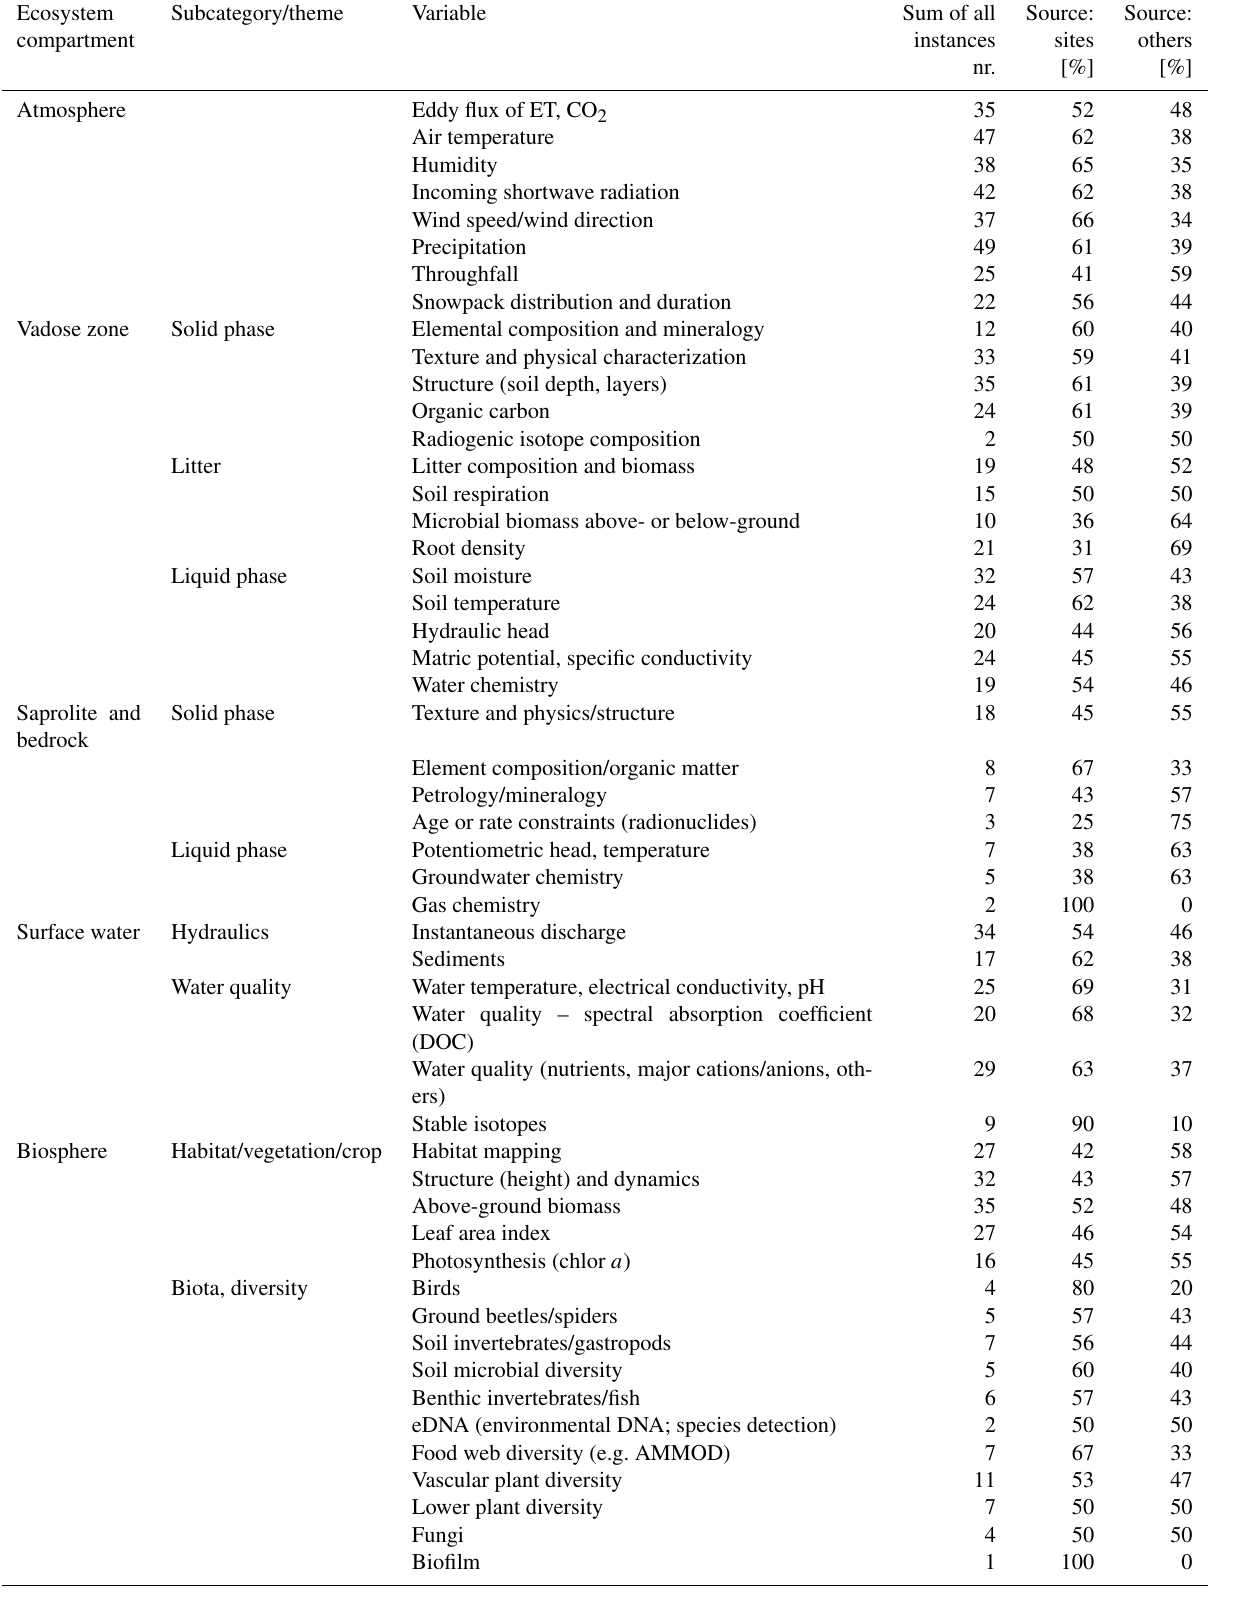
Table A1. Summary table of variables, associated ecosystem compartment, and the times it was associated with a model, the source for the data being either from site observation or from another source: i.e. remotely sensed, modelled, external database, literature.